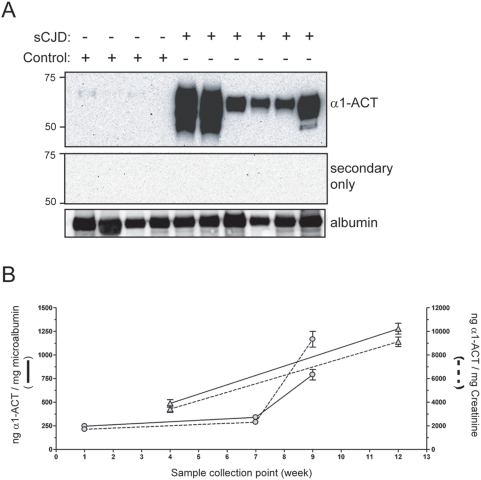
Urinary α1-ACT of sCJD patients.(A) Equivalent amounts (50 µg) of urinary protein from sCJD patients and appropriate age-matched controls were fractionated under non-reducing SDS-PAGE conditions and subsequently analyzed by Western blot using an anti-human α1-ACT monoclonal antibody. A duplicate blot incubated with HRP-labeled secondary antibody alone is shown. To verify equivalent protein loading, blots were stripped and re-probed with anti-albumin antibodies. Molecular weight marker positions are indicated. α1-ACT levels are significantly higher in sCJD patient urine, corroborating the data obtained by ELISA measurement. (B) ELISA measurement of α1-ACT in urine collected sequentially during the clinical phase of disease of two sCJD patients (represented as circles or triangles) indicates a progressive increase in α1-ACT levels normalized both for albumin and creatinine. Error bars represent the standard deviations in replicate measurements of each sample.